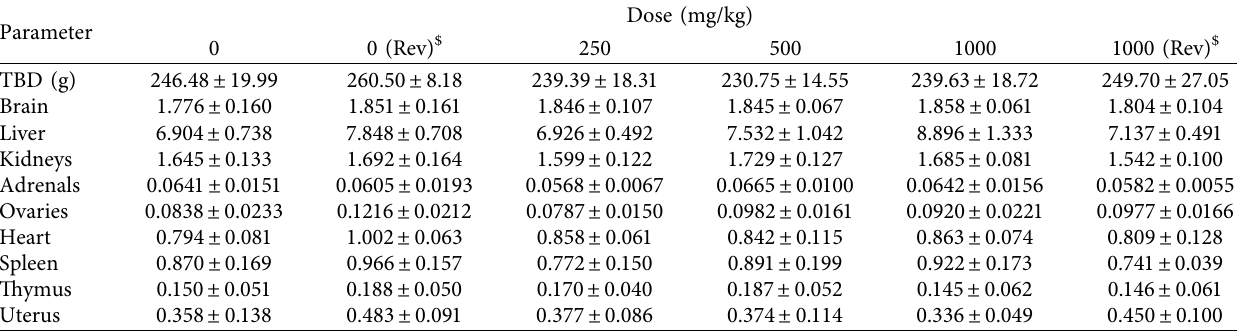
Table 11: Effect of GutGard on absolute organ weights (g) of female rats during 90D oral toxicity study. Parameter